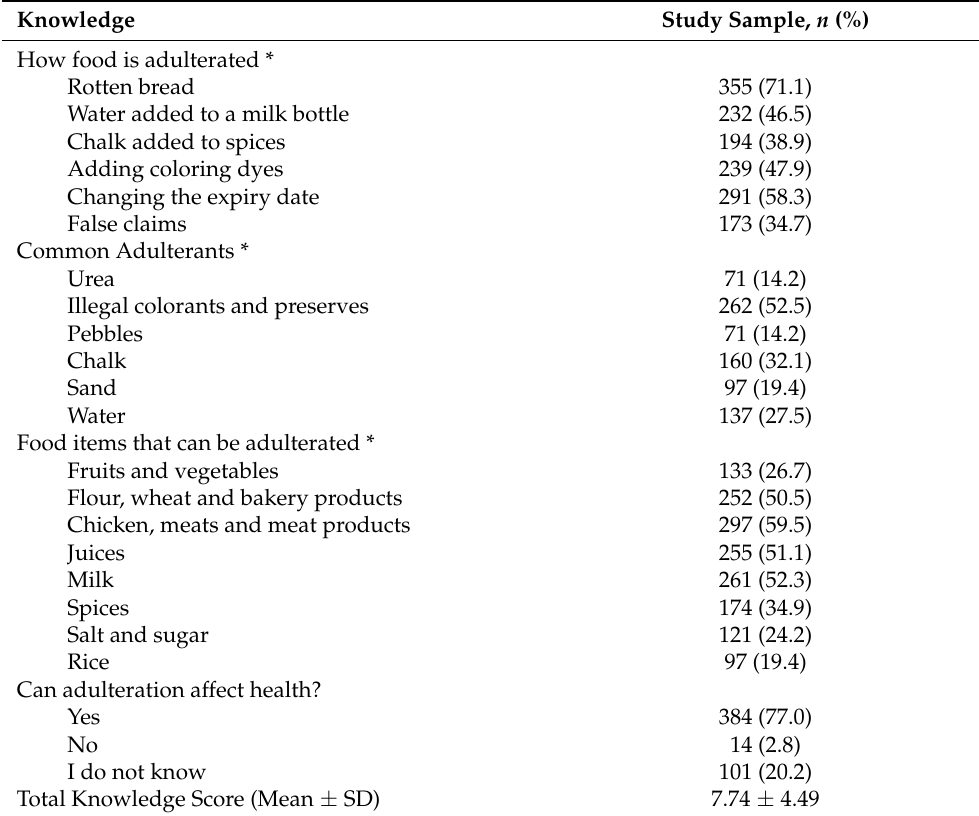
Table 2. Knowledge of food adulteration of the